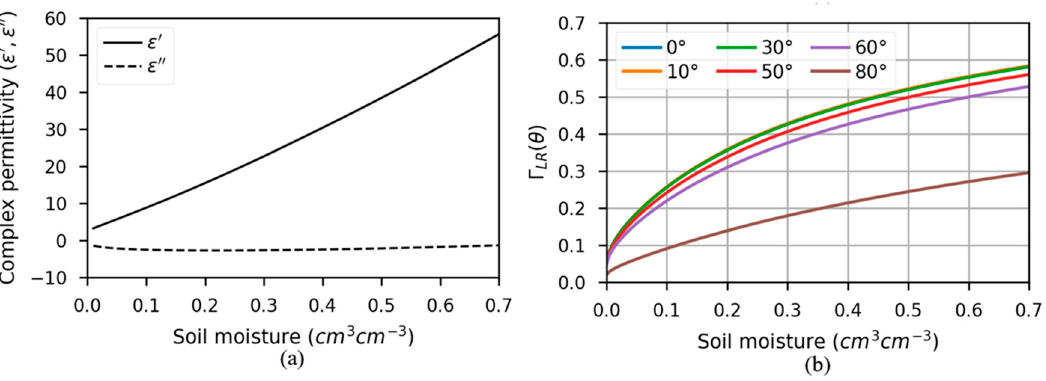
Figure 2. Complex permittivity under different soil moisture ( a ) and the relationship between soil moisture and reflectivity at the different signal incidence angle ( b ).